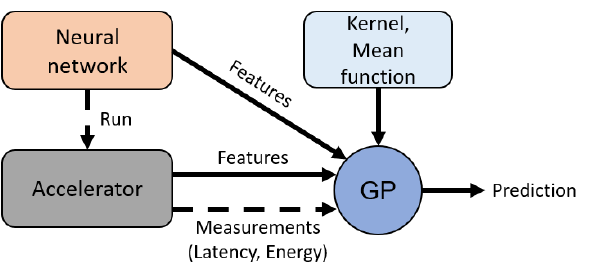
Figure 1. Overview of the proposed prediction methodology based on a Gaussian process